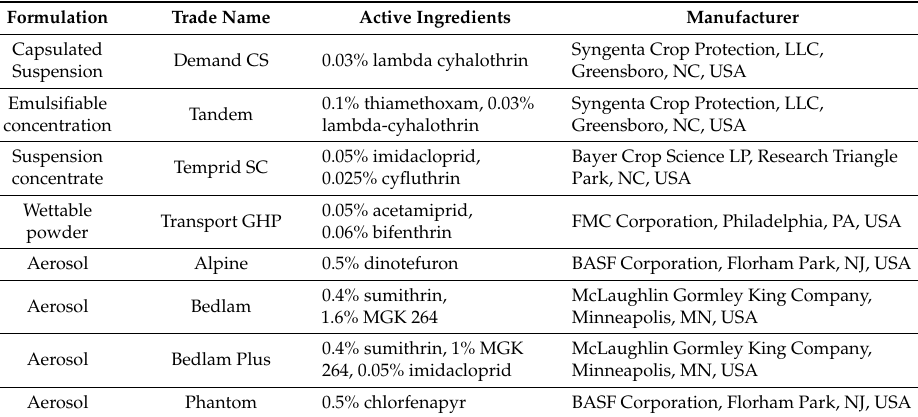
Table 1. Insecticides evaluated in the